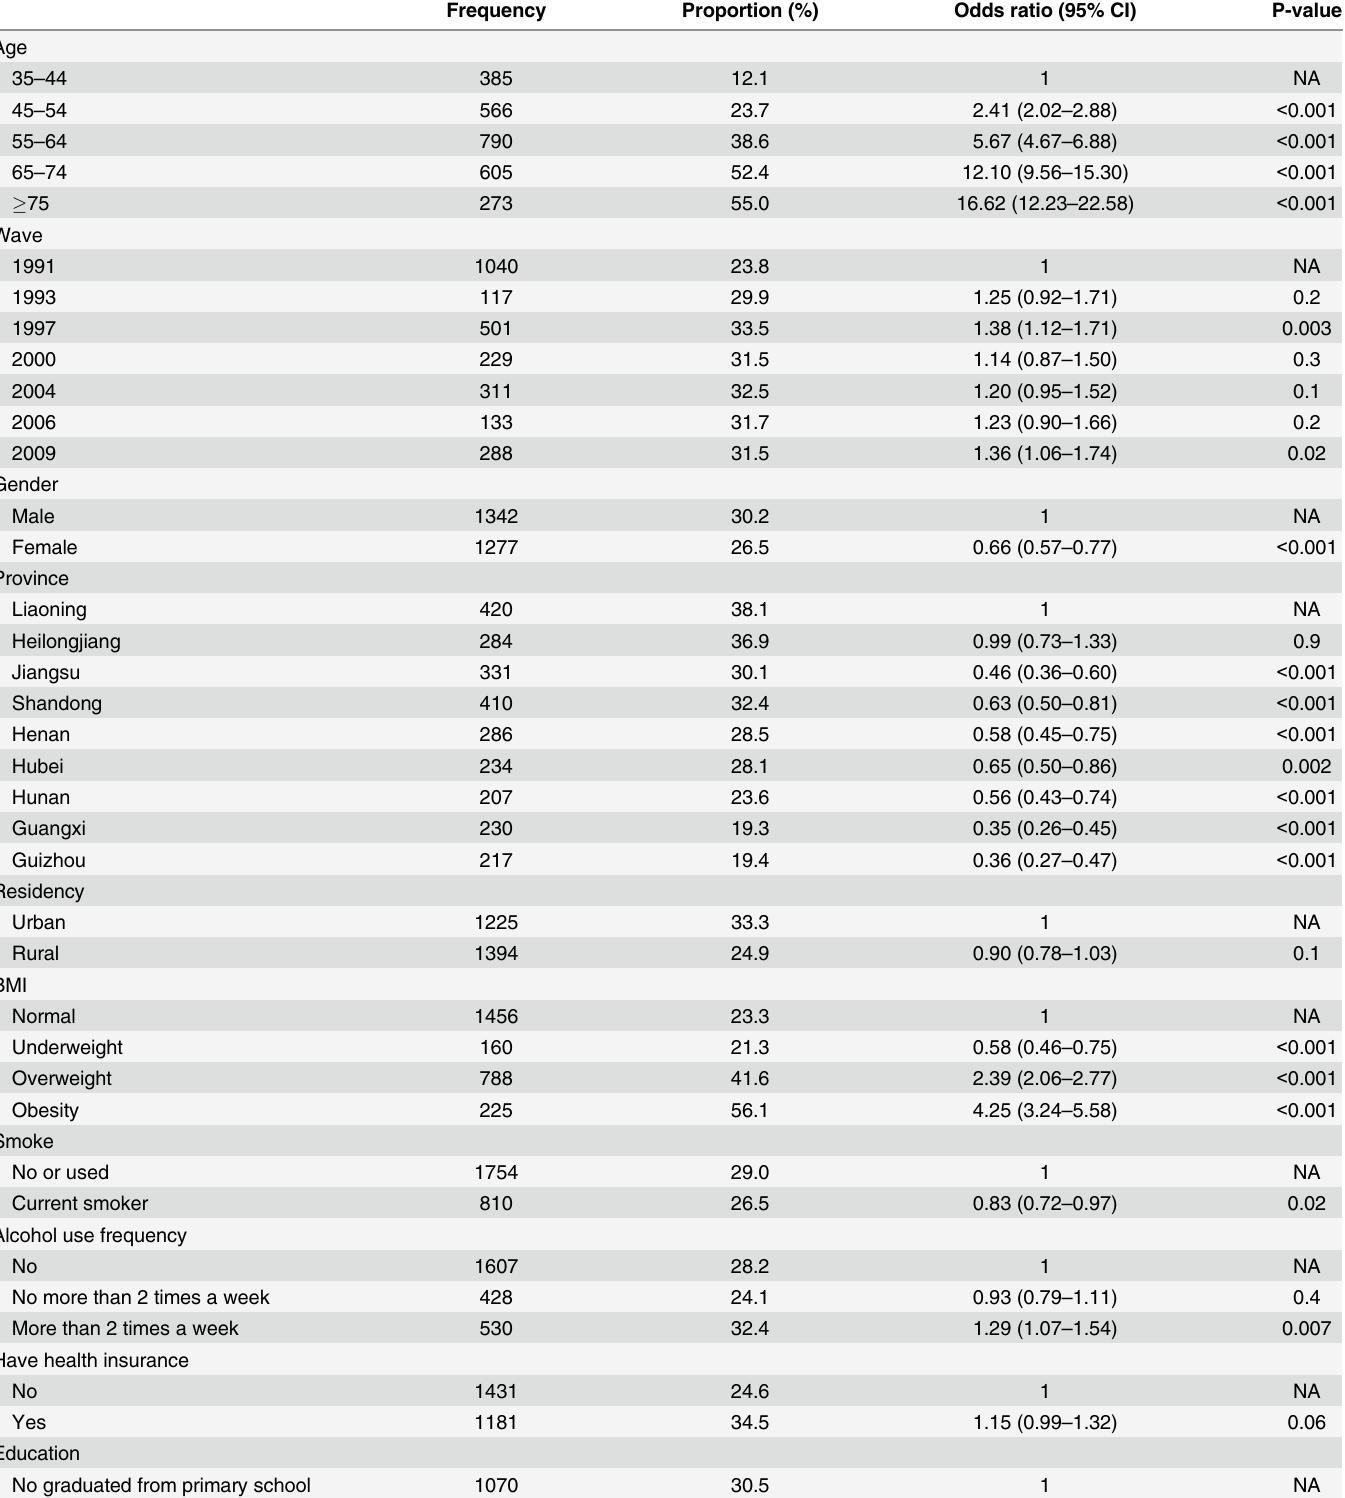
Table 2. Prevalence of hypertension by key risk